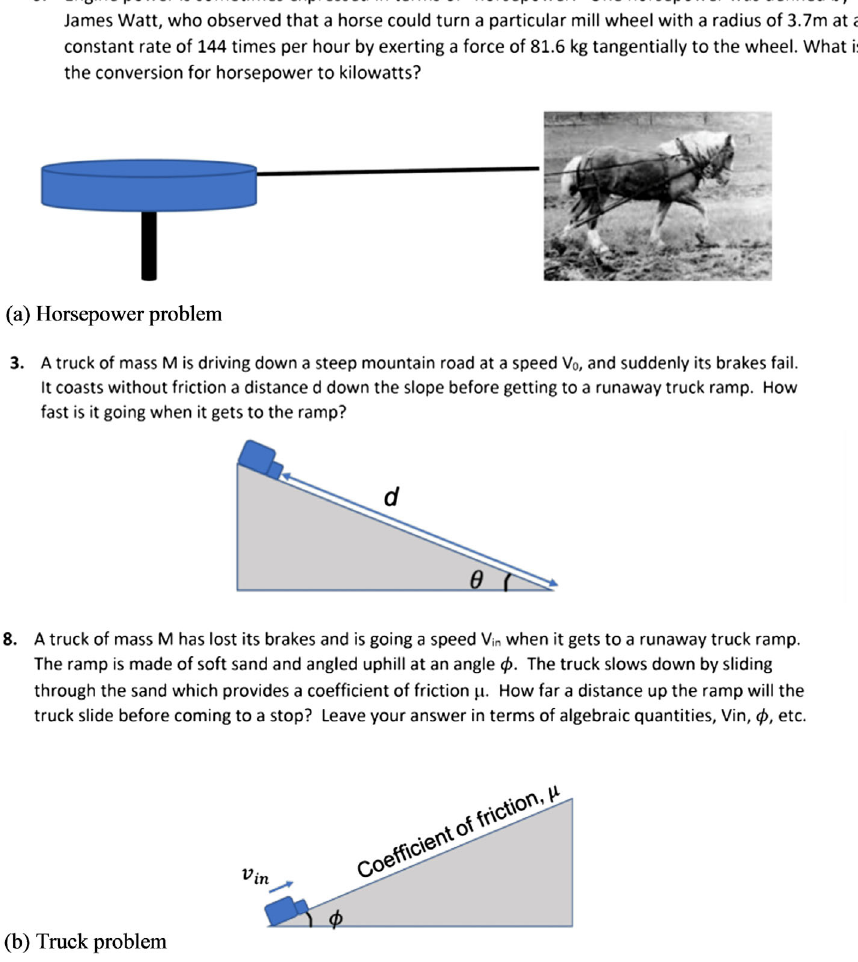
FIG. 5. Horsepower problem (a) and truck problem (b) from the Physics 41E final